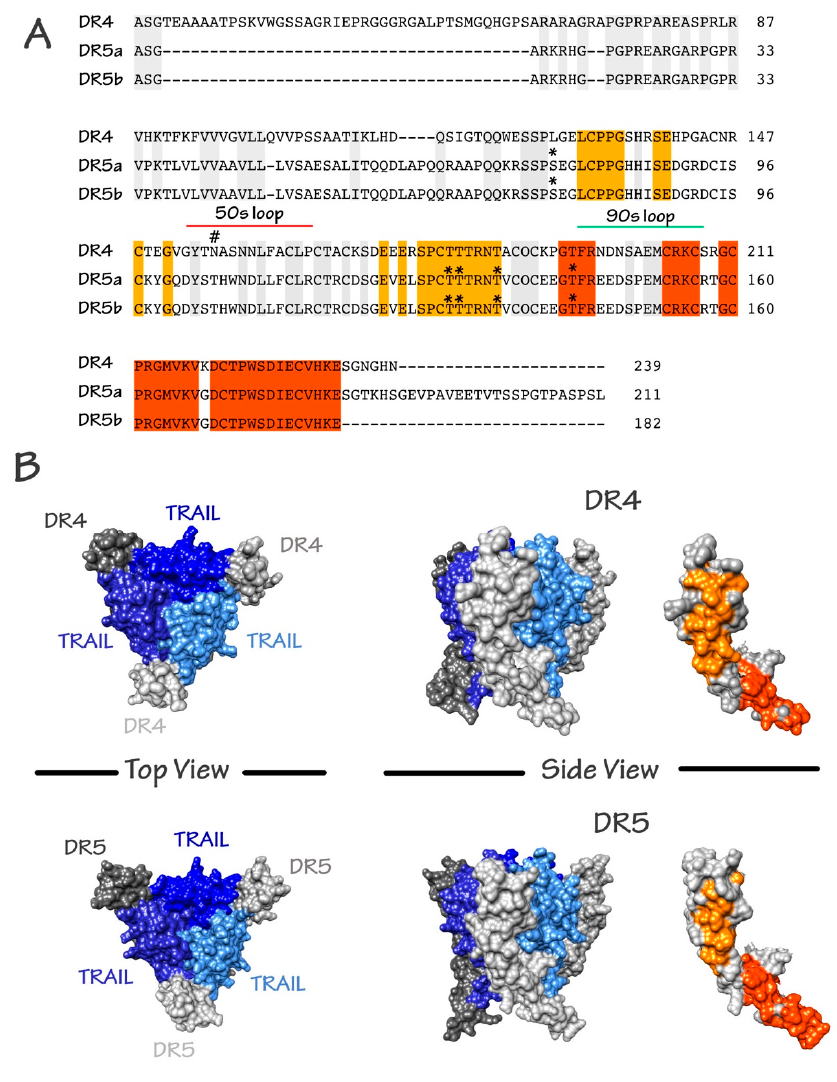
Figure 2. Schematic representation of the amino acid composition of TRAIL agonist receptors and crystallographic structure of the TRAIL/receptor complexes. ( A ) Alignment of DR4, DR5a, and DR5b. Sequence identity is shown. Orange and red patches correspond to shared surface residues; ( B ) Surface representation of trimeric TRAIL with DR4 and DR5 from the crystallographic structures 1D4V [42] and 5CIR [43], respectively. Top and side views are shown. Shared surface residues between DR4 and DR5 are shown by the two patches (orange and red). Buried or non-shared residues are shown in grey. In the trimeric representations, TRAIL monomers are shown as cornflower, medium, and dark blue. DR4 or DR5 monomers are shown in grey. DR4 and DR5 N -glycosylation and O -glycosylation sites are depicted with the following symbols # and *, respectively.